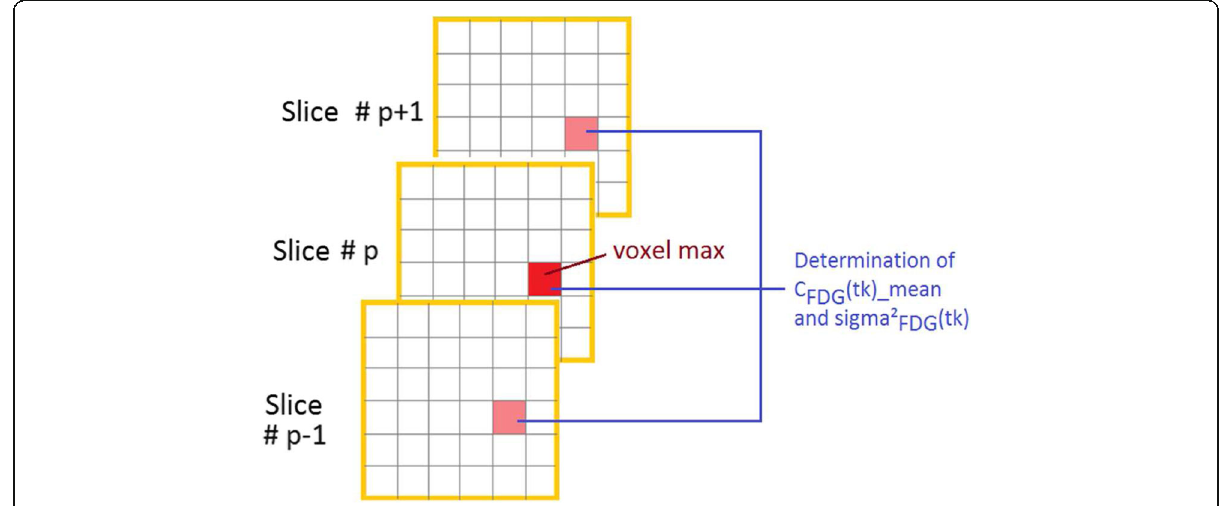
Fig. 1 Barbolosi ’ s determination of C FDG ð t k Þ and σ 2